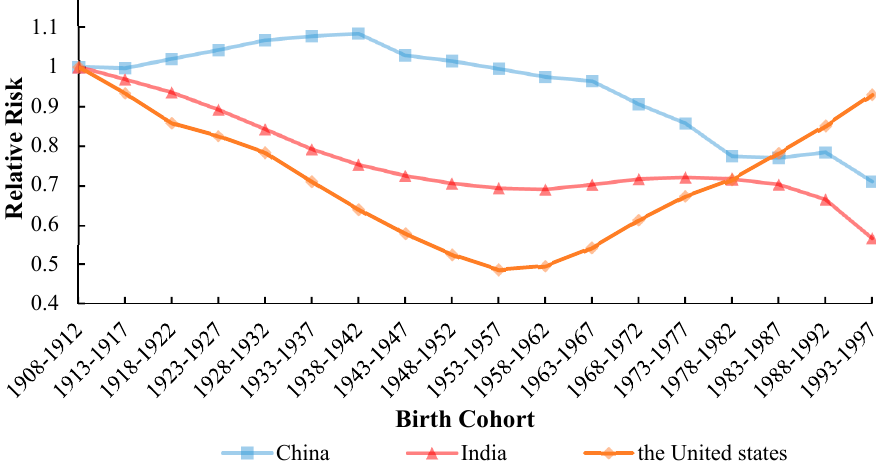
Figure 8. Cohort e ff ects on TB incidence rate for China, India, United States, from 1992 to